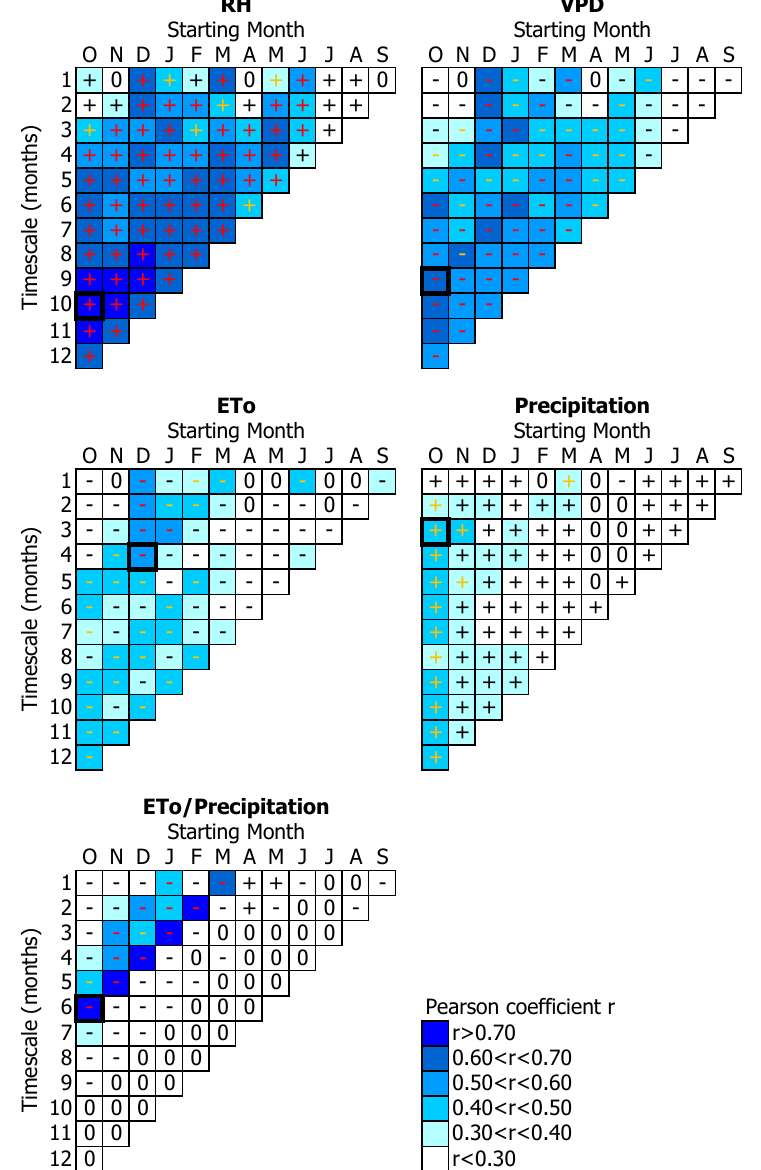
Figure 5. Pearson coefficients ( r ) derived from the correlation of annual TRWI with relative humidity (RH), vapour pressure deficit (VPD), evapotranspiration (ETo), precipitation (P) and ETo / P. The positive correlations are indicated with “ + ”, the negative with “-” and the negligible ( − 0.1 < r < 0.1) with “0”. The significance level is indicated with red ( p < 0.01), orange ( p < 0.05) or black (not significant) signs, while the strongest correlation (highest absolute r value) per parameter is marked with broader line.